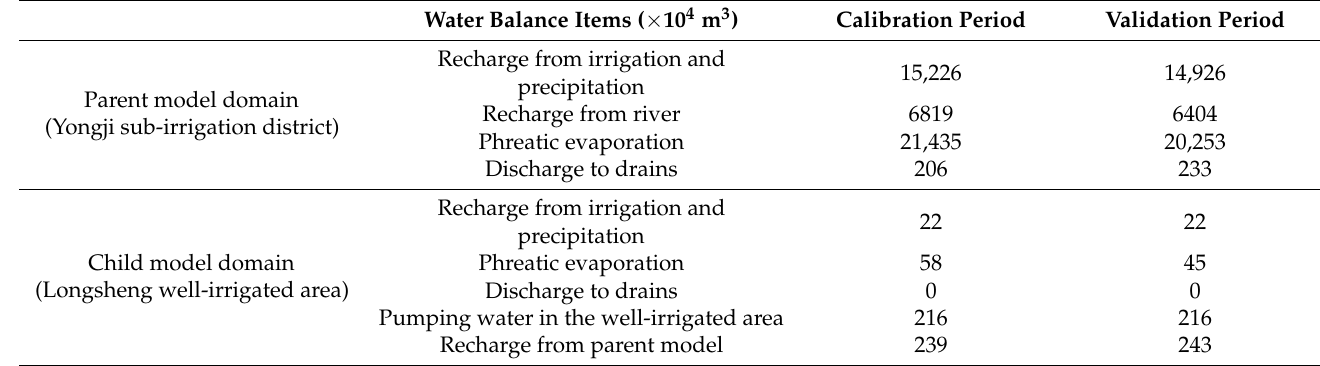
Table 4. Annual average water balance items in the parent and child domains during the calibration and validation periods.